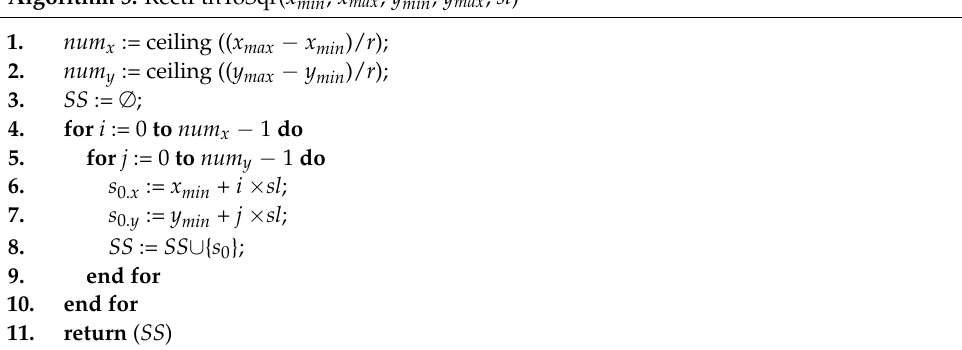
Algorithm 5. RectPtnToSqr( x min , x max , y min , y max , sl )